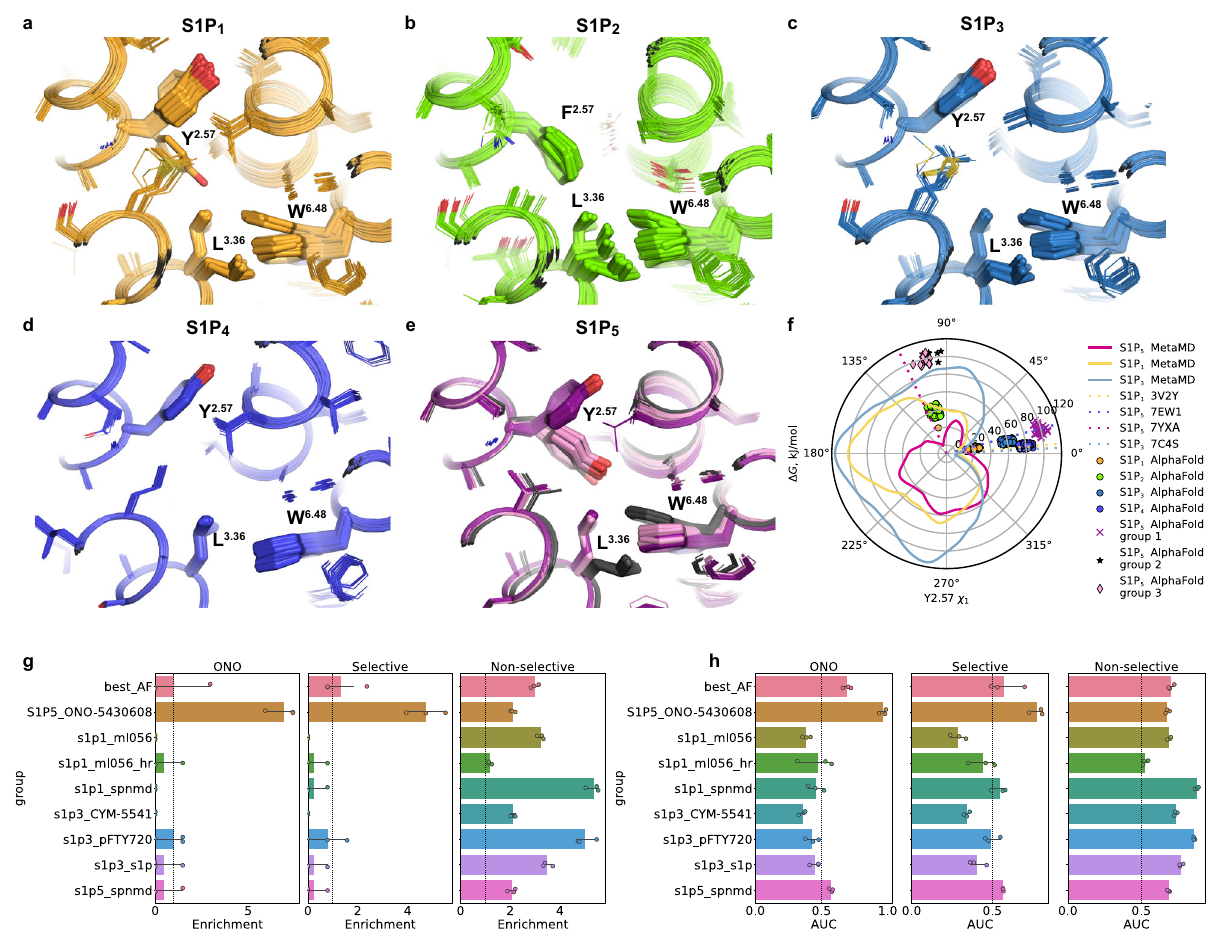
Fig. 5 | AlphaFold prediction of S1PR structures. a – e Conformations of Y 2.57 and the dual toggle switch L 3.36 -W 6.48 in 50 AlphaFold models of each S1P 1 – 5 subtype, respectively. Three distinct conformations of S1P 5 are shown in dark violet, light violet,andblack. f Freeenergypro fi lesoftheY 2.57 side-chaintorsionangle χ 1 inS1P 1 (yellow line), S1P 3 (blue line) and S1P 5 (pink line) calculated by metaMD. Dotted lines correspond to Y 2.57 conformations in experimental structures. Individual